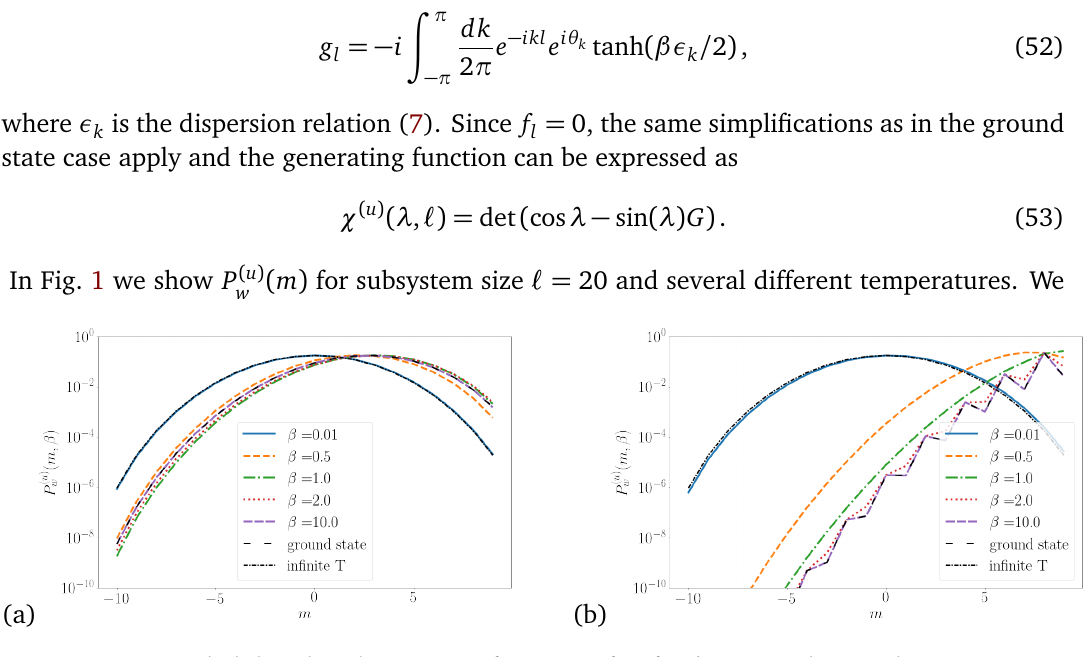
Figure 1: Probability distribution as a function of m for (cid:96) = 20 and several tempera- tures at (a) h = 0.5; (b) h = 2.